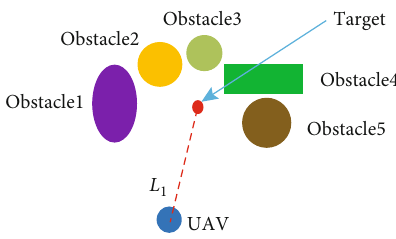
Figure 6: Example 1: the parallel search strategy for UAV when the goal is unreachable.